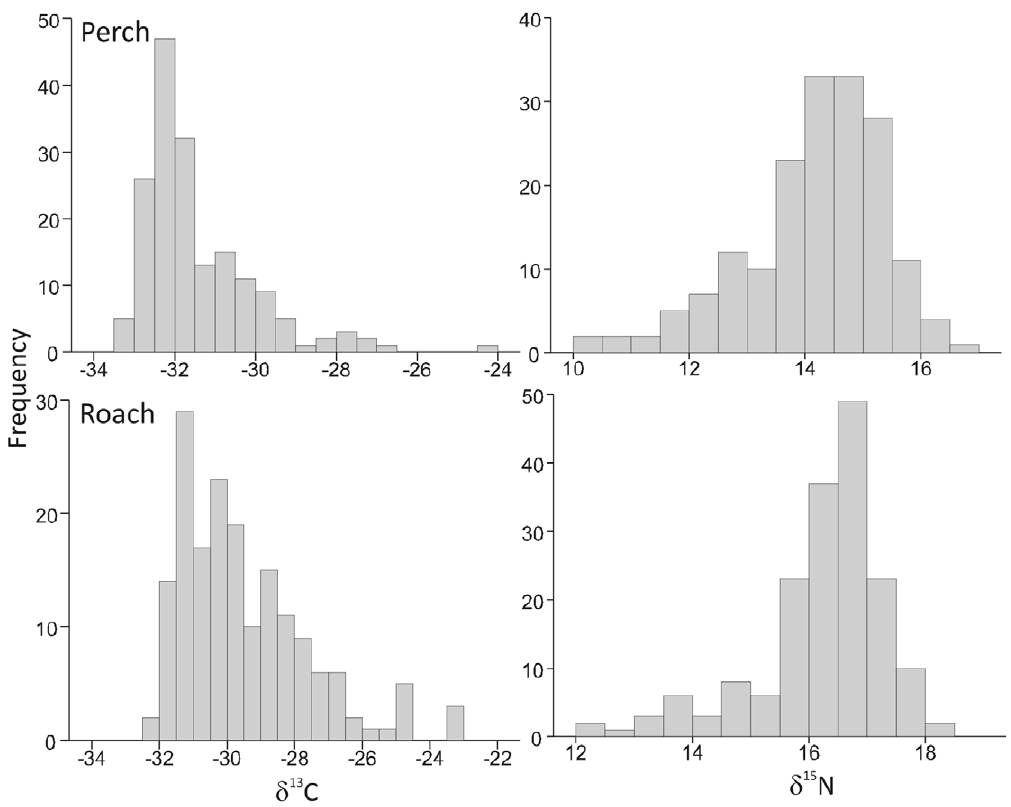
Figure 2. Frequency distributions for d 13 C and d 15 N values in empirical data set used in this study. Isotope values of perch (upper panels) and roach (lower panels) populations from Lake Jyva¨sja¨rvi showing their peaked and skewed distributions (Skewness: perch d 13 C=1.896, d 15 N= 2 1.443; roach d 13 C=1.162, d 15 N= 2 0.883 Kurtosis: perch d 13 C=4.816, d 15 N=2.501; roach d 13 C=1.239, d 15 N=0.746).